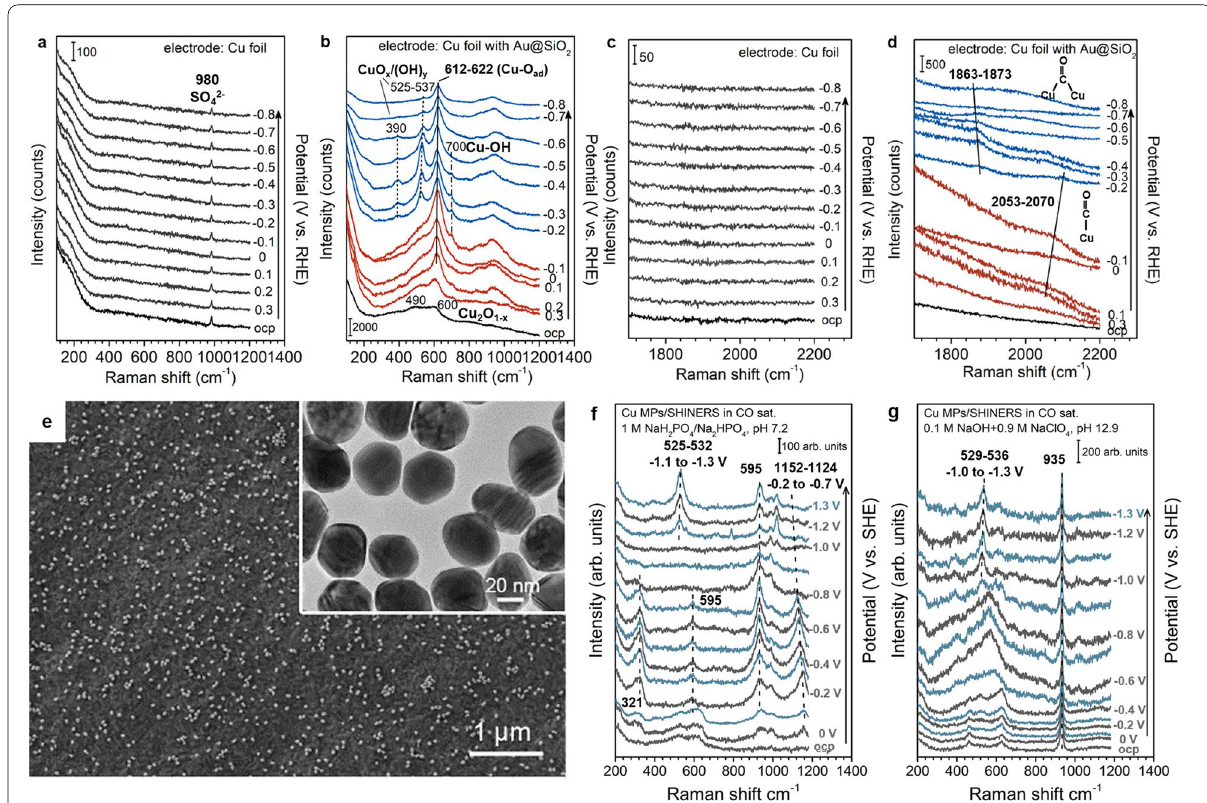
Fig. 7 In situ Raman spectra measured at various potentials on a , c a Cu Foil and b , d a Cu foil with Au@SiO 2 . The measurement was conducted in a CO-saturated electrolyte to probe the surface species during CORR (0.01 M KOH and 0.045 M K 2 SO 4 , pH 11.7), e SEM image of Cu foil with Au@SiO 2 (inset image: TEM image of Au@SiO 2 ) reproduced with permission from [15]. Copyright (2020) American Chemical Society. In situ Raman spectra measured at various potentials on f Cu microparticle in CO-saturated 0.3 M NaH 2 PO 4 /0.35 M Na 2 HPO 4 (pH 7.2). g Cu microparticle in CO-saturated 0.1 M NaOH/0.9 M NaClO 4 (pH 12.9), reproduced with permission from [47]. Copyright (2021) Springer